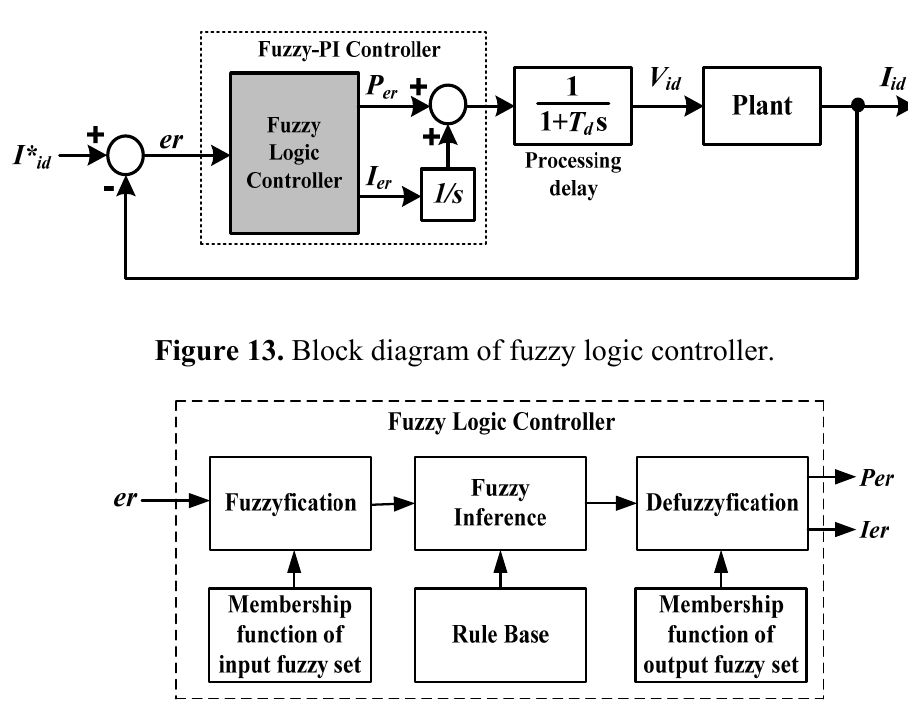
Figure 12. Current control loop of the grid side converter (GSC).